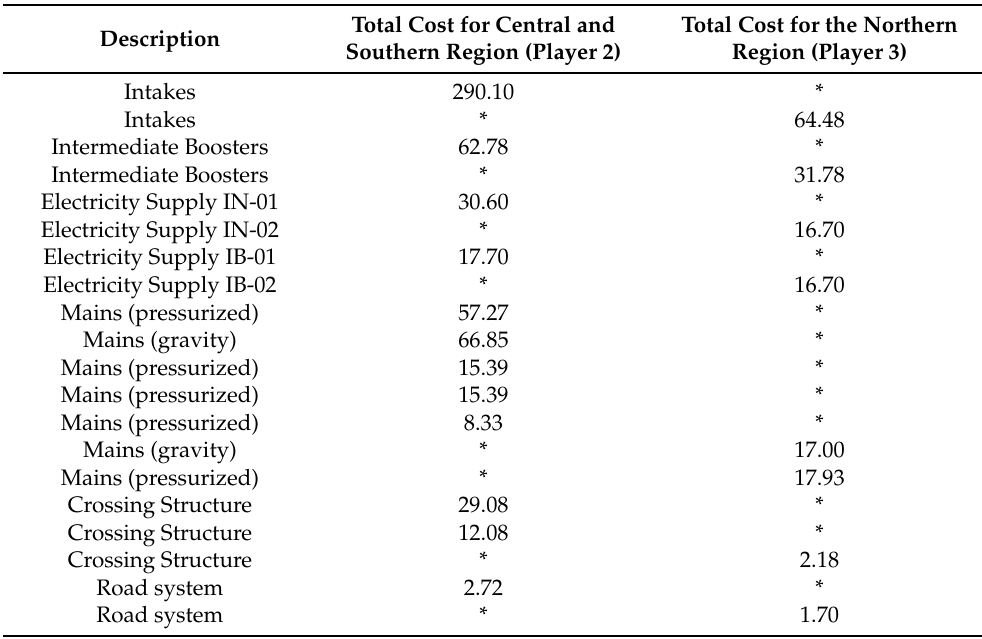
Table 4. Costs in Game c A2,2